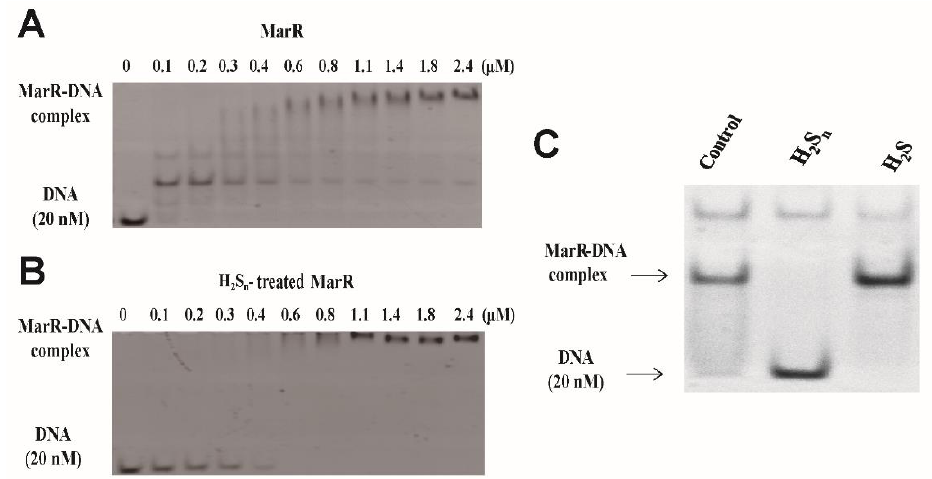
Figure 1. MarR reacts with sulfane sulfur, decreasing its affinity to its DNA probe. ( A , B ) EMSA analysis of MarR and H 2 S n -treated MarR in the presence of 20 nM the DNA probe (100 bp) containing the MarR-binding sequence. ( C ) The purified MarR (9 µM) was treated with 800 µM H 2 S n and H 2 S for 20 min. Then 20 nM DNA probe was incubated with 0.2 µM MarR for the shift assay.